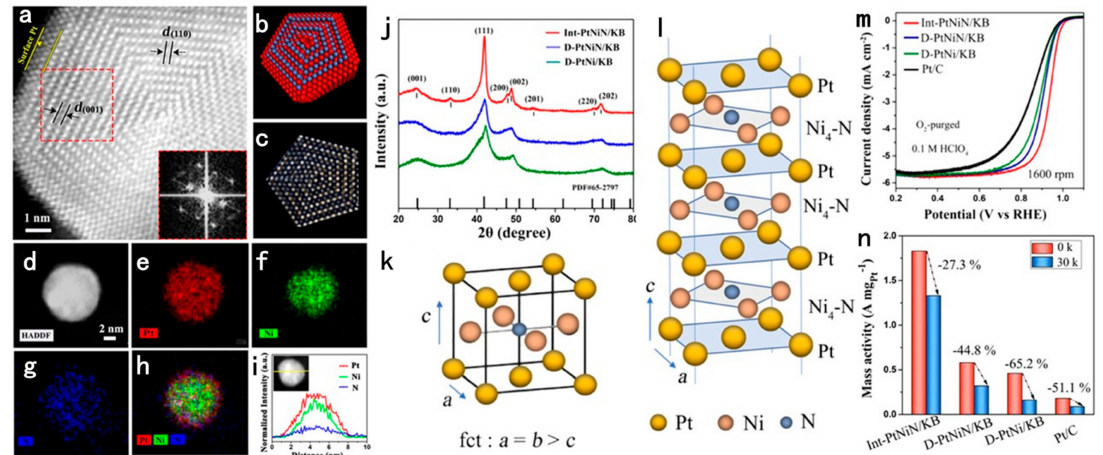
Figure 8. ( a ) STEM image of Int-PtNiN/KB with three Pt atoms at the surface. The inset shows the corresponding electron diffraction pattern (indicated by red dashed squares). ( b ) Schematic of Int-PtNiN/KB with three surface Pt atomic layers, where the red-colored atom is Pt and the blue-colored atom is Ni. ( c ) Simulated HAADF-STEM image of IntPtNiN/KB. ( d – h ) HAADF-STEM image of a single Int-PtNiN/KB particle along with its EDX mapping. ( i ) EDX elemental line scan across the single Int-PtNiN/KB particle. ( j ) XRD patterns of Int-PtNiN/KB (9 h, NH 3 ), D-PtNiN/KB (2 h, NH 3 ), and D-PtNi/KB (9 h, H 2 /Ar) samples annealed at 560 ◦ C. ( k ) L1 0 -type structure with a nitrogen atom at the center of fct (N of Ni − N is 4). ( l ) Schematic of the ordering structure alternating Ni 4 − N moieties and Pt planes. ( m ) ORR polarization curves of commercial Pt/C, D-PtNi/KB, D-PtNiN/KB, and Int-PtNiN/KB in a 0.1 M HClO 4 acidic solution (sweep rate = 10 mV s − 1 ). ( n ) MA comparison of Int-PtNiN/KB, D-PtNiN/KB, D-PtNi/KB, and Pt/C before and after 30,000 potential cycles